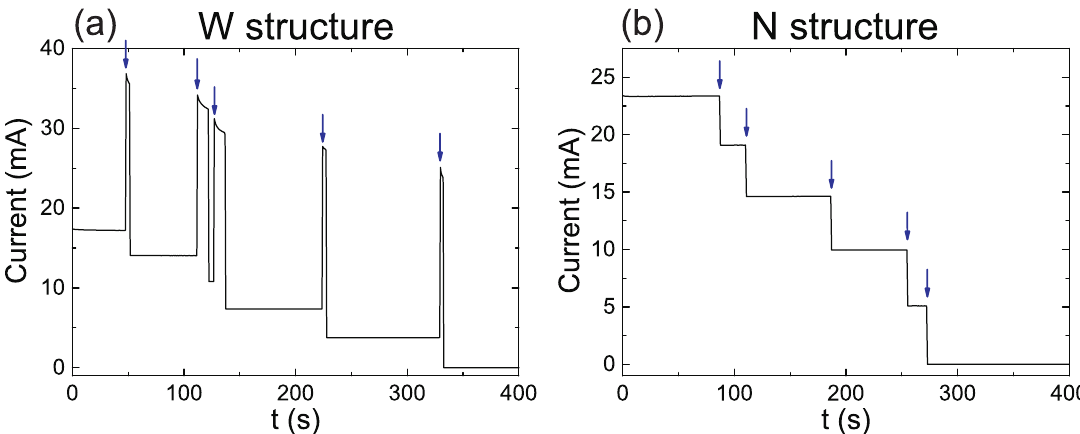
Figure 2. Exemplary single stress measurements for a voltage level of 3.15 V. ( a , b ) show the cases for the structure with wide (W) and narrow (N) fuse layers.